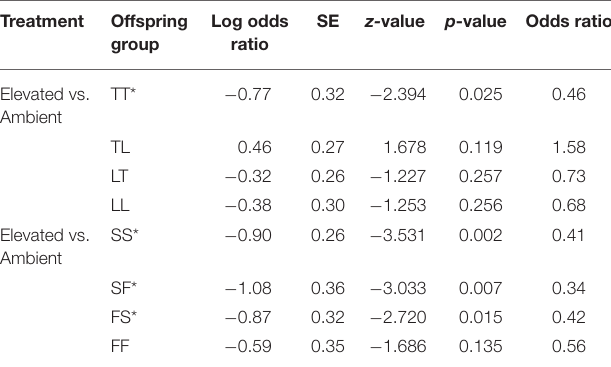
The abbreviation of the offspring groups is that the first letter represents the origin of the eggs and the second letter the origin of sperm. An odds ratio of > 1 indicates higher survival, and < 1 indicates lower survival under elevated treatment. * Indicates significant differences in survival under different treatments in this offspring group.